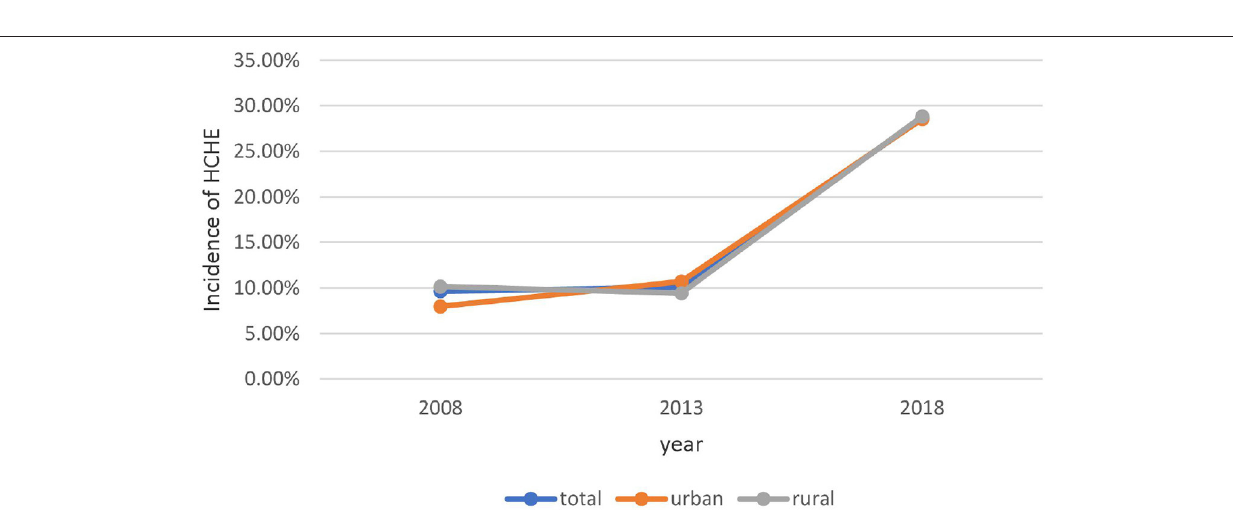
FIGURE 2 | Trends in HCHE incidence among residents of urban and rural areas from 2008 to